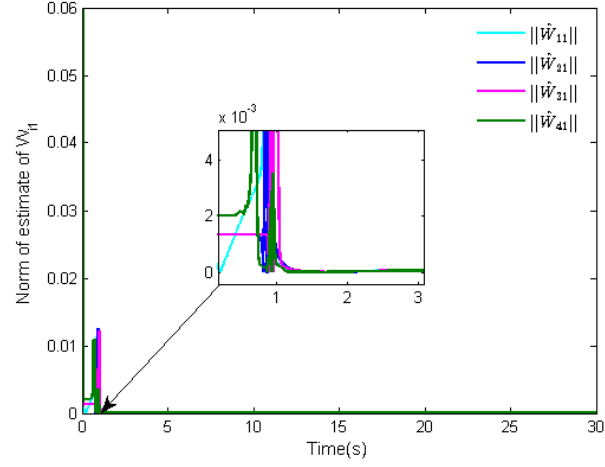
Figure 15. The curves of the norm for the adaptive control law ˆ W i 1 .